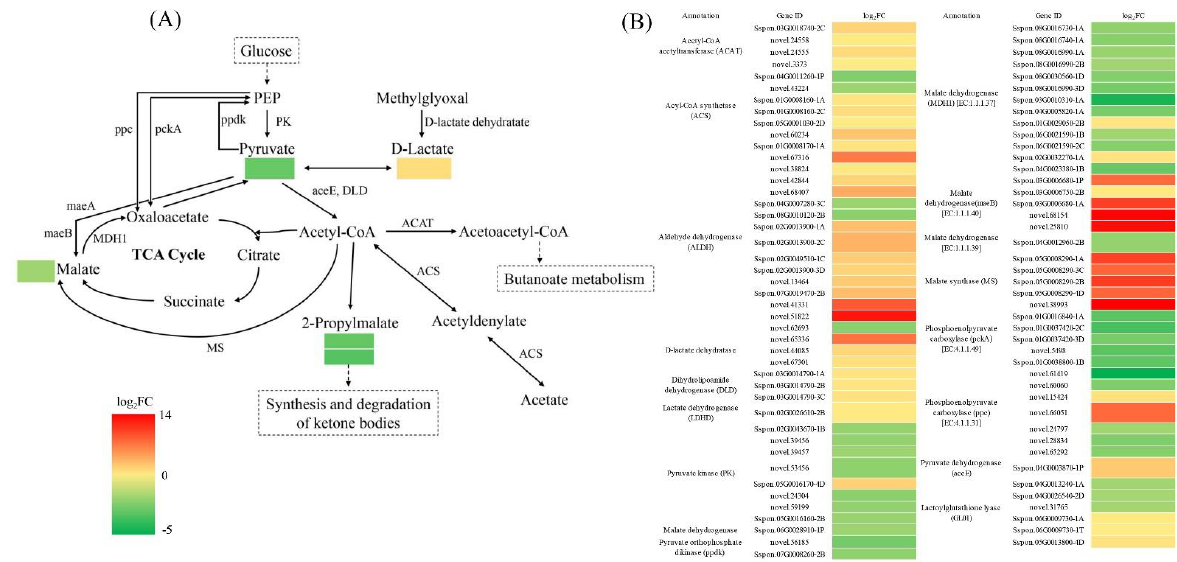
Figure 5. Analysis of DEGs and SDMs in the pyruvate metabolic pathway for the CG/DS group. ( A ) Metabolic pathways examined in KEGG analysis. ( B ) Genes involved in KEGG metabolic pathways. Color-coding in A and B corresponds to observed fold-change.